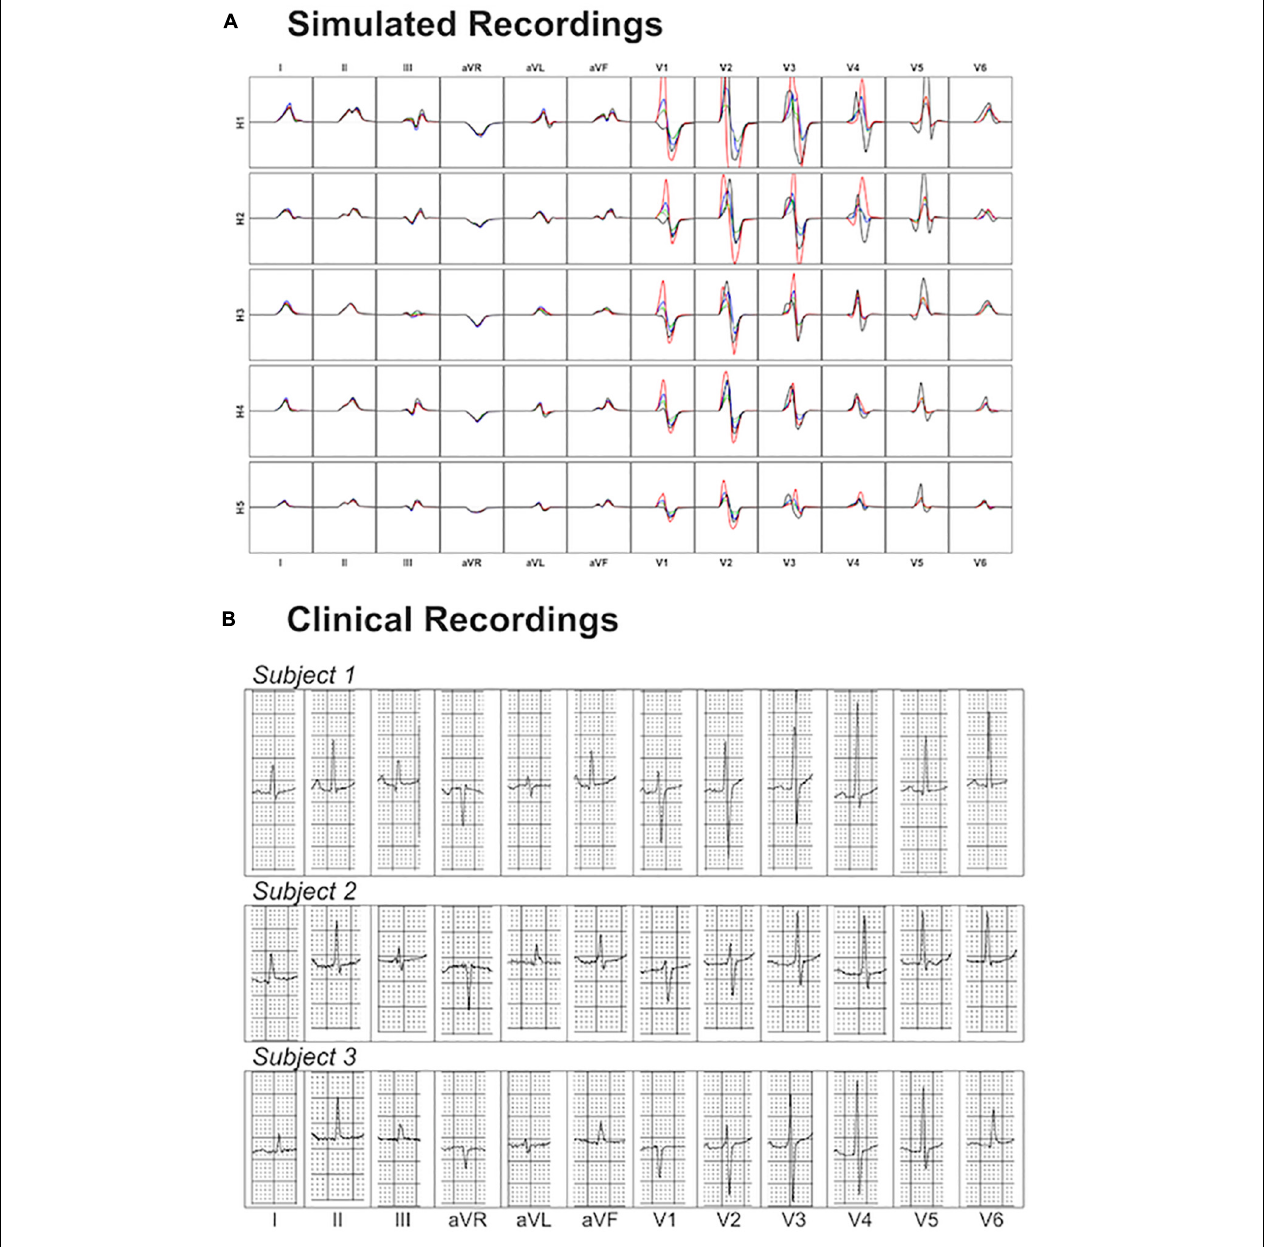
FIGURE 8 | Comparison between simulated and clinical 12-lead ECG recordings. Panel (A) shows the simulated 12-lead QRS complexes obtained using each of the ventricular models (H1–H5) placed in the five different torsos-poses. Panel (B) shows three exemplary clinical 12-lead ECG recordings from healthy